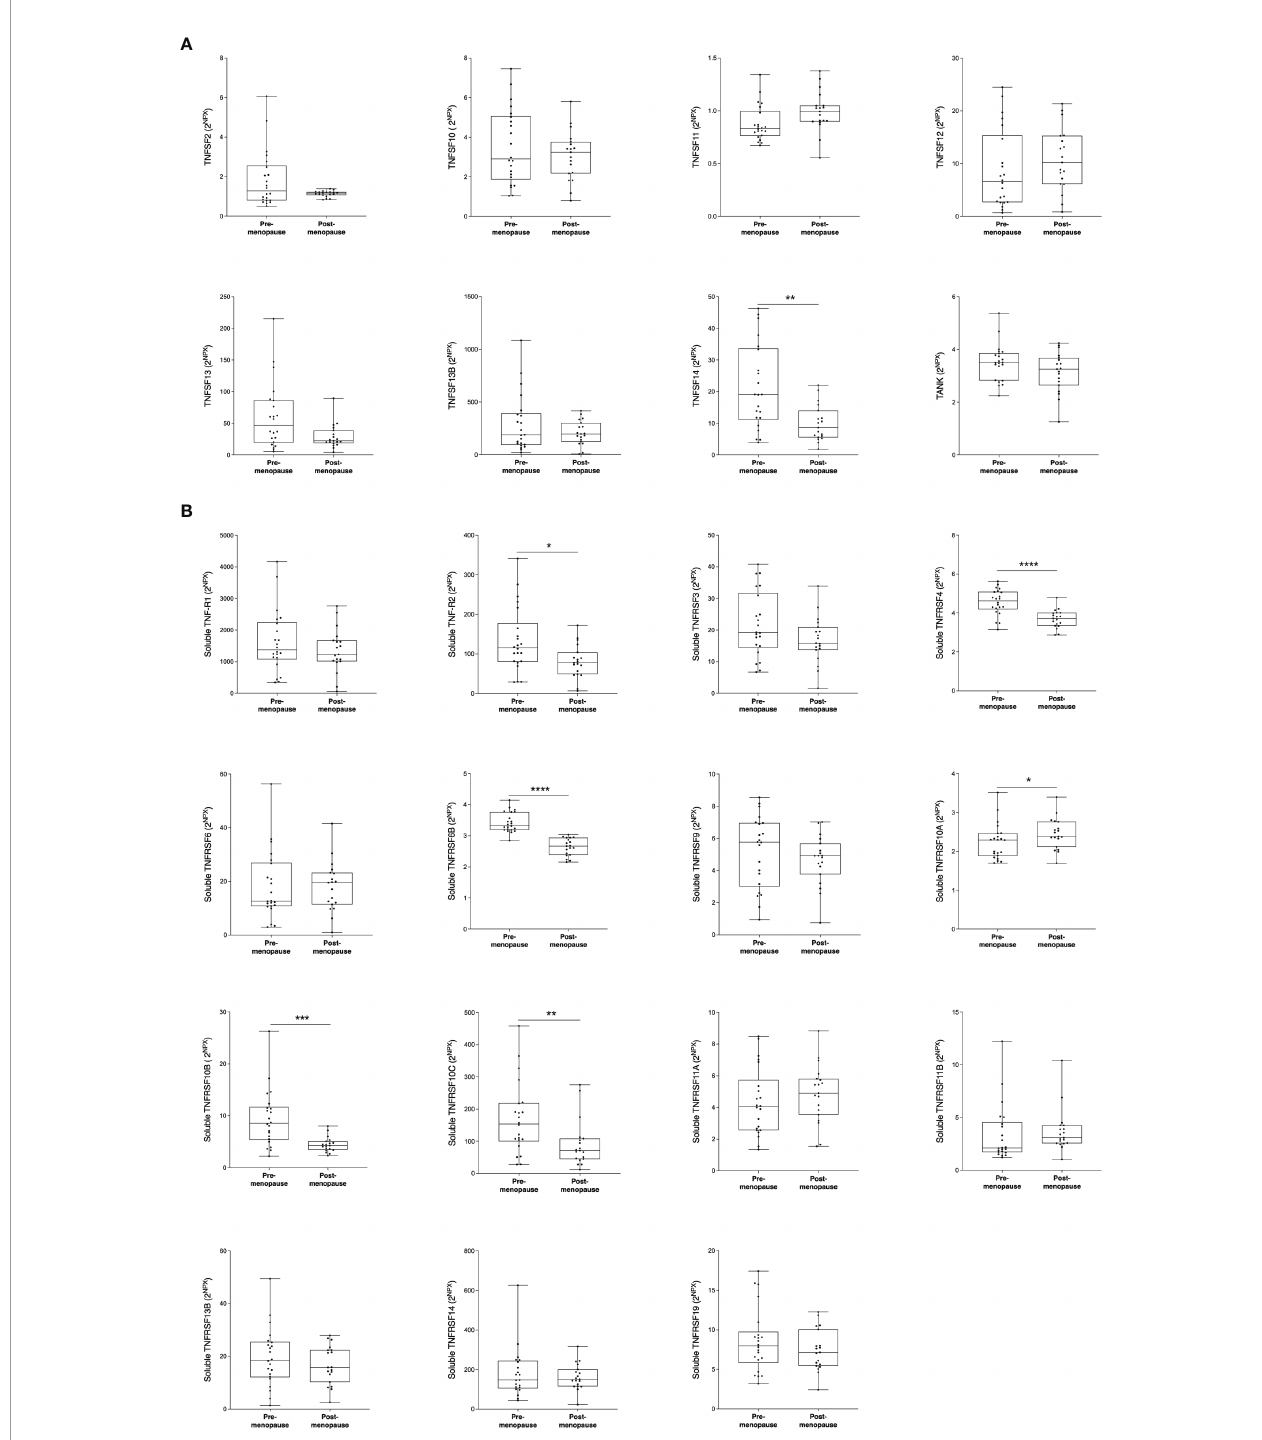
FIGURE 6 | Local levels of TNFSF/sTNFRSF in abdominal s.c. fat. The women described in Figure 5 were subjected to microdialysis of the abdominal s.c. fat at the same time point as the microdialysis of breast tissue. Proteins were quanti fi ed in the microdialysate as described in the materials and methods section. Mann Whitney U-test was used. Data are displayed as box plots with median and 10 – 90 percentile. * P < 0.05, ** P < 0.01, *** P < 0.001, **** P < 0.0001. (A) TNF ligands (TNFSFs) (B) Soluble TNF receptors